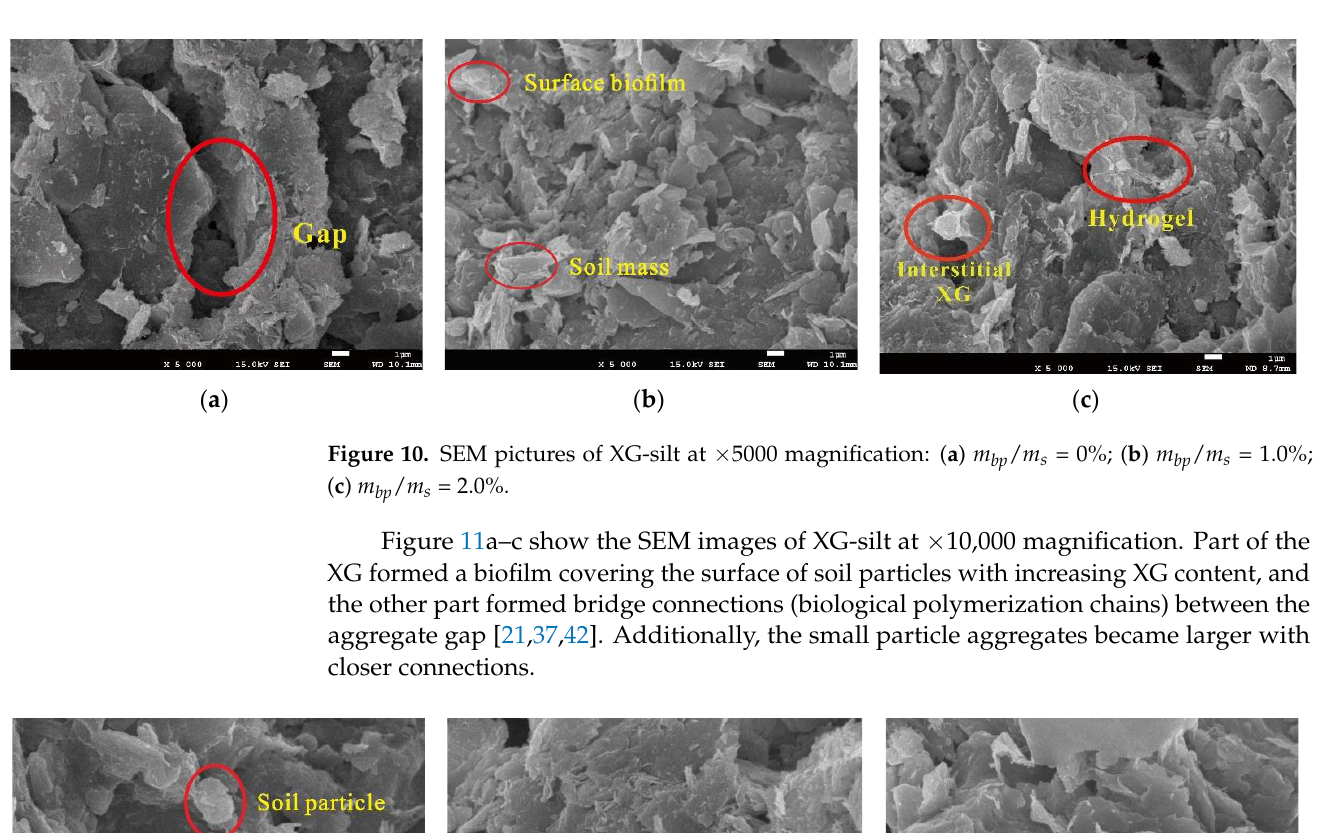
Figure 9. SEM pictures of XG-silt at ×2000 magnification: ( a ) m bp / m s = 0%; ( b ) m bp / m s = 1.0%; ( c ) m bp / m s = 2.0%.